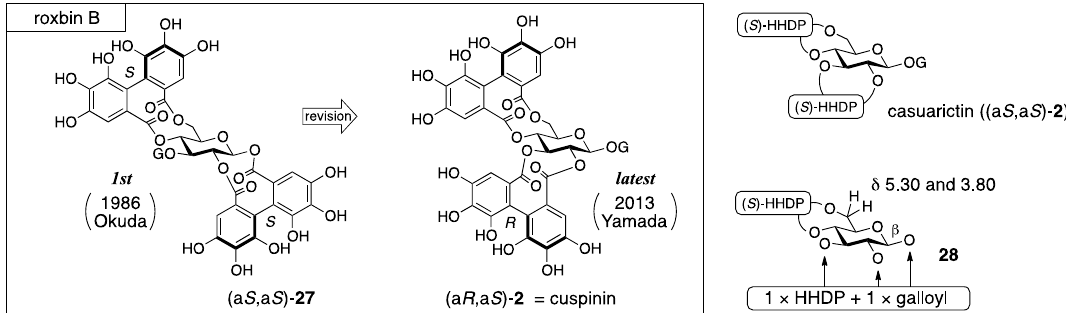
Figure 14. The transition of the structure of roxbin B, the structure of casuarictin ((a S ,a S )- 2 ), and the reliable partial structure 28 of roxbin B.